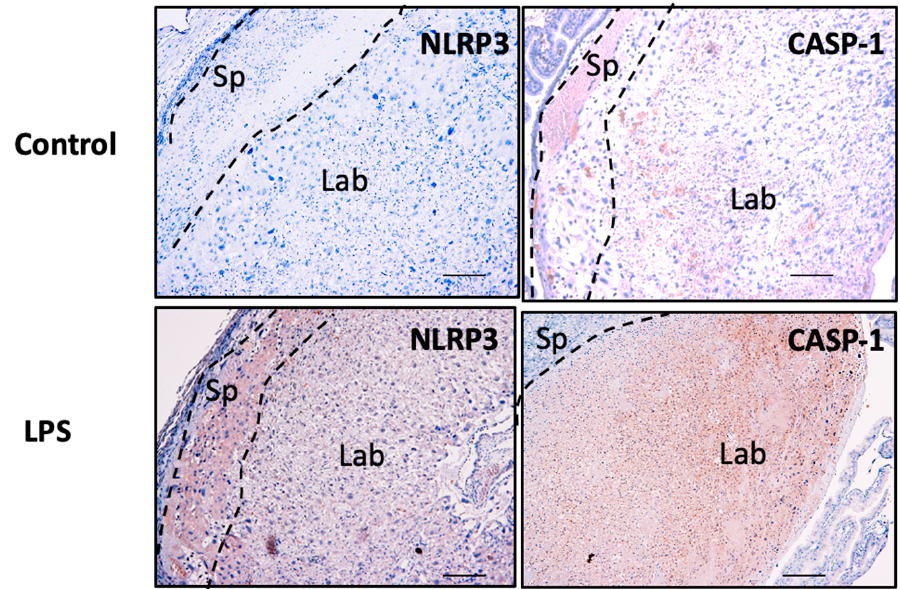
Figure 11. Placental NLRP3 and caspase-1 protein in murine pregnancy in vivo. Placental NLRP3 and caspase-1 expression levels associated with inflammation are investigated using immunohistochemistry in the placentae obtained from LPS-induced inflammation in a murine model of pregnancy. As shown, NLRP3 localisation is observed in the spongiotrophoblast (Sp) and labyrinth (Lab) in the placentae from both control and LPS-treated mice. Scale bar denotes 100 µm.